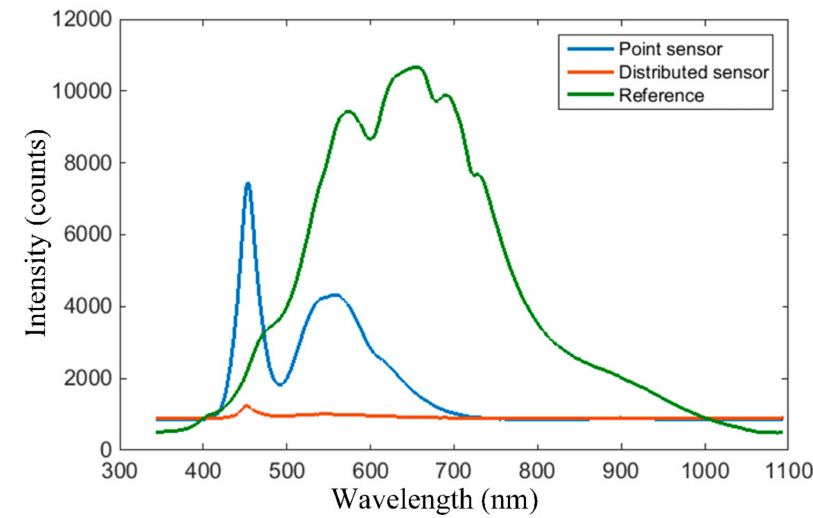
Figure 14. Spectrum of the blank system, i.e., in the absence of the analyte, with a blue line for the point sensor (with white LED source), orange for the extended sensing area sensor (with white LED source), and green line for the reference system (with Tungsten Halogen source).